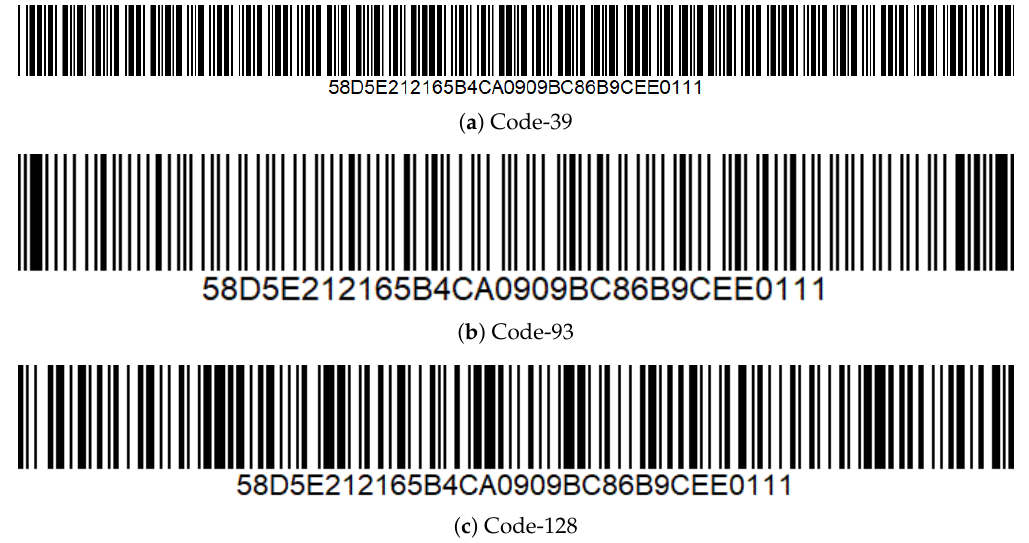
Figure 5. A 32-character hexadecimal value, rendered in a number of one-dimensional bar code types.